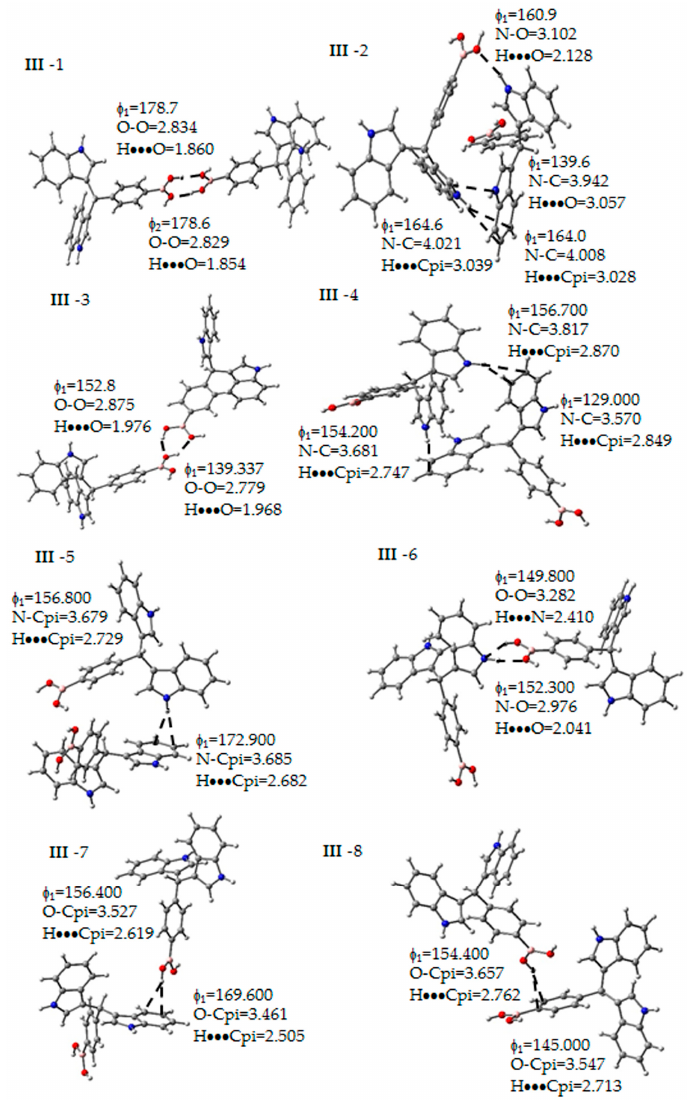
Figure 5. Non-covalent interactions determined between the molecules of III . Some geometrical parameters as bond length and angle are next to the bond. The gray, blue, pink, red and white spheres are for carbon, nitrogen, boron, oxygen and hydrogen atoms respectively.